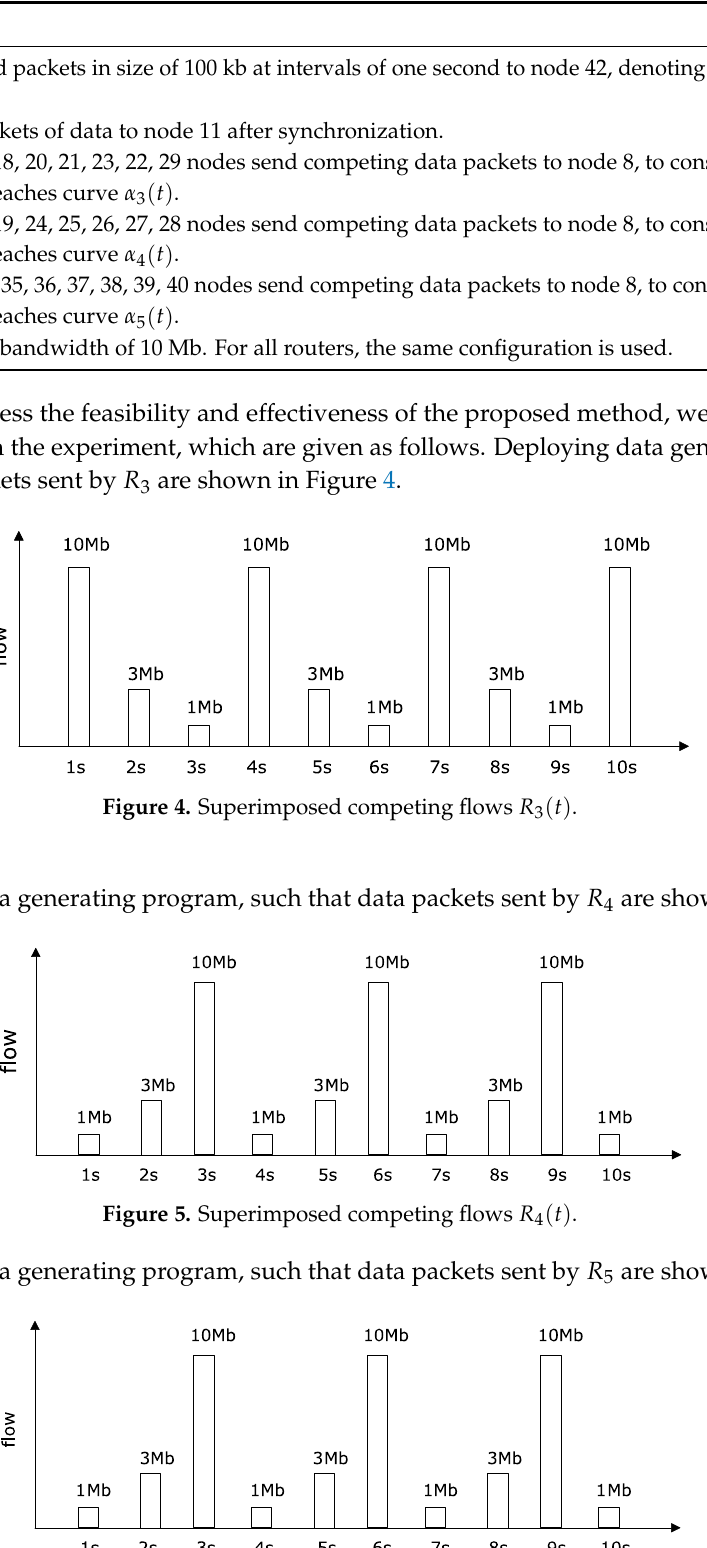
Figure 3. Network topology diagram of the synchronization delay test.